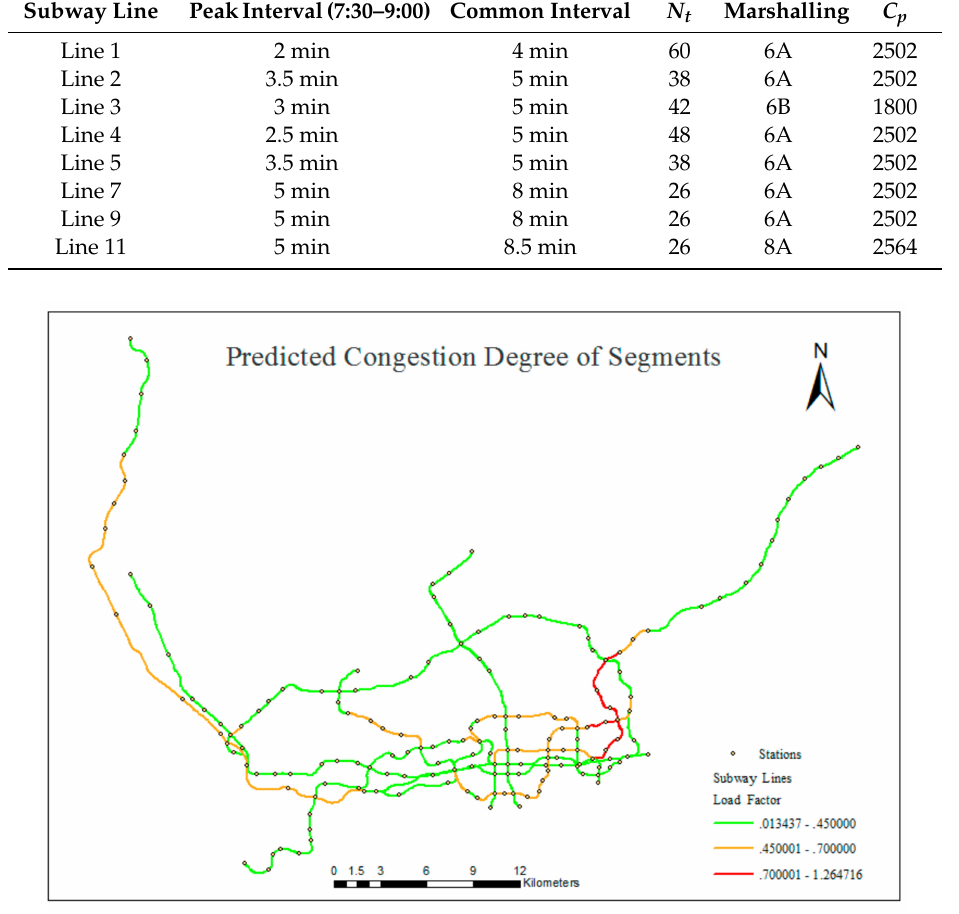
Figure 10. Predicted degree of congestion of subway